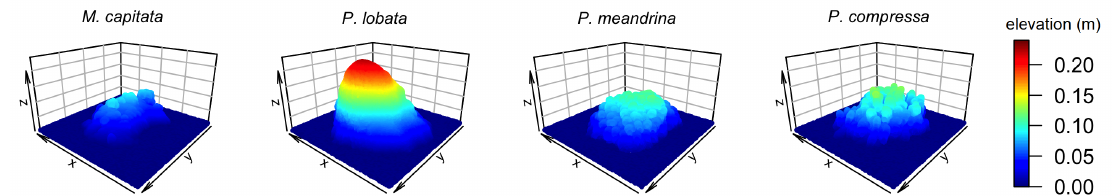
Figure 3. Three-dimensional visualization of four coral colonies with different morphologies with a substratum: encrusting M. capitata , mounding P. lobata , branching P. meandrina and branching P. compressa